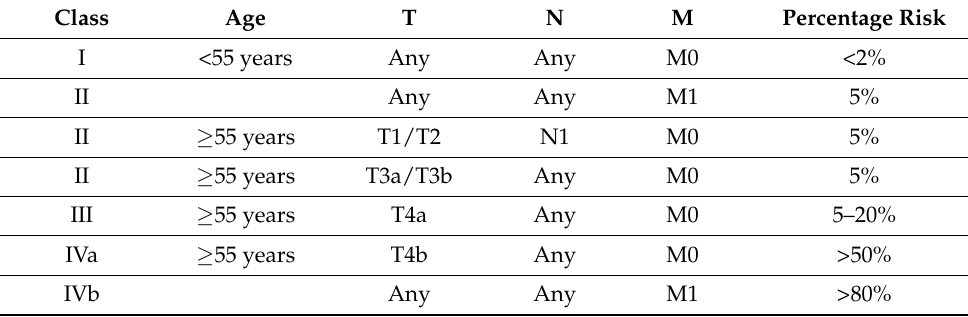
Table 1. Risk of cancer-related death for DTC by TMN